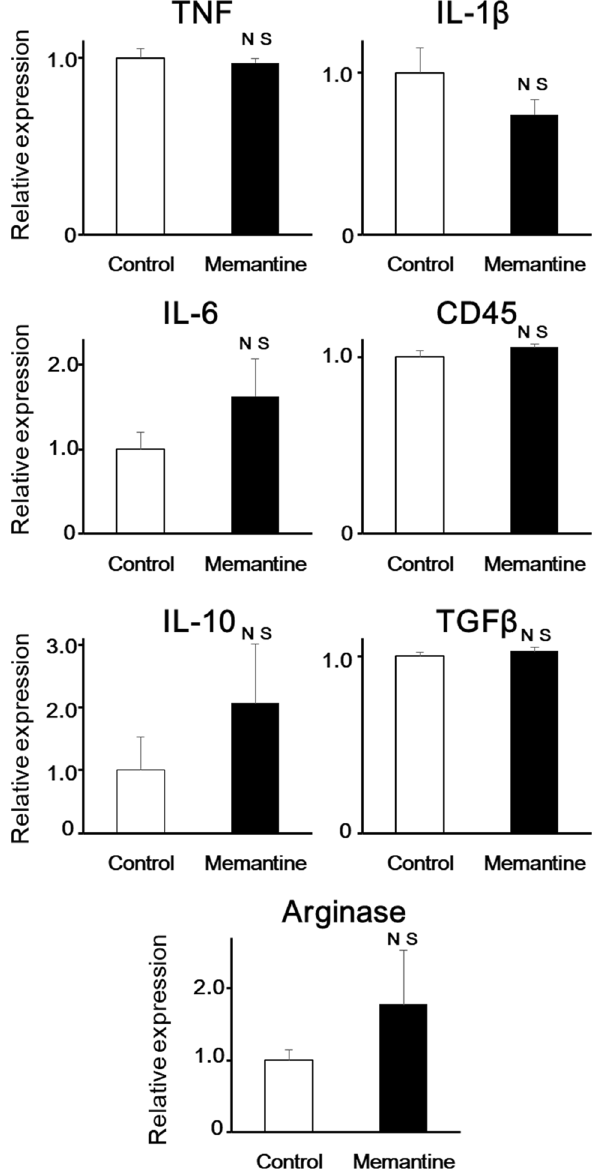
Figure 3. Pretreatment with memantine did not affect the mRNA expression of both pro- and anti- inflammatory phenotypes in mouse primary microglial cells. Bar graphs showing the effects of pretreatment with memantine on mRNA expression of TNF, IL-1β, IL-6, CD45, IL-10, TGF-β, and arginase in mouse primary microglial cells. NS not significant vs